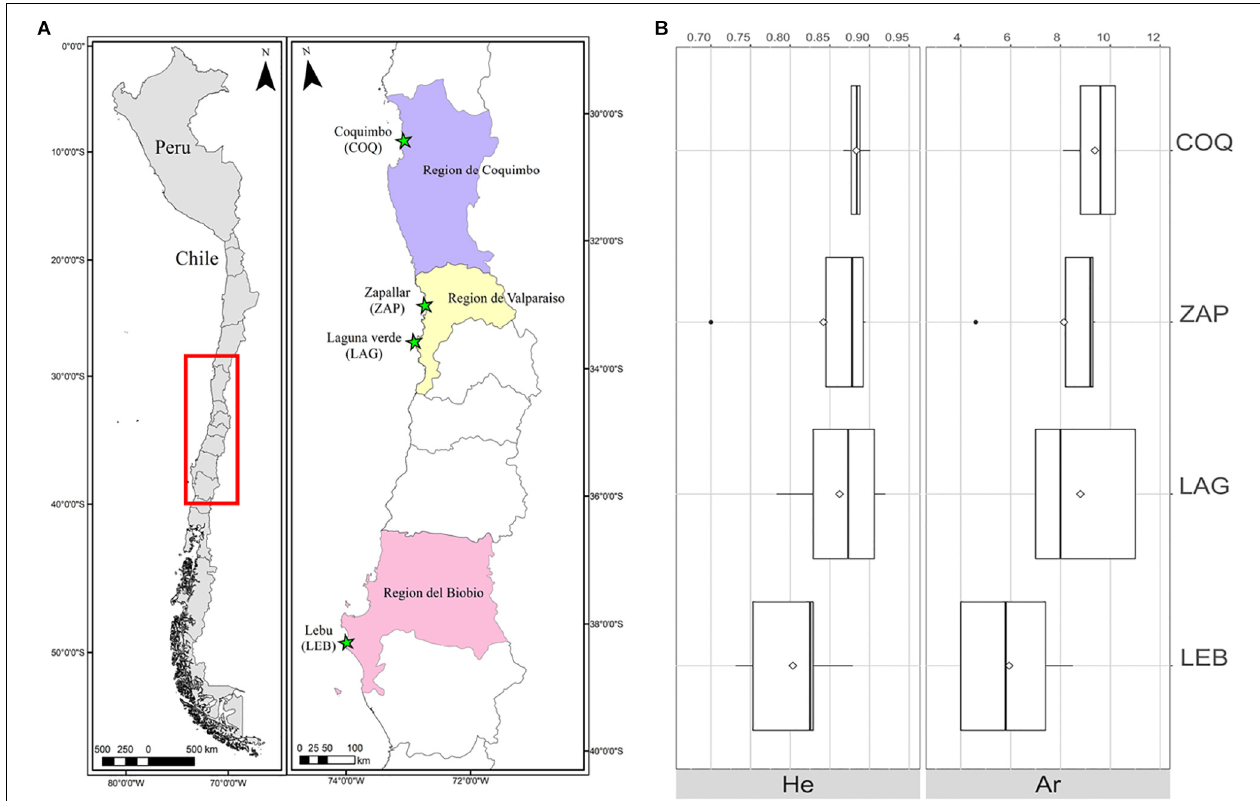
FIGURE 2 | (A) Map of sampling locations in Chile. Stars show the four sampling locations across the Chilean coast, encompassing 1,000 kilometers of G. chilensis distribution range. (B) Boxplot of expected heterozygosity and Allelic richness per location. White diamonds represent the mean for each estimate.